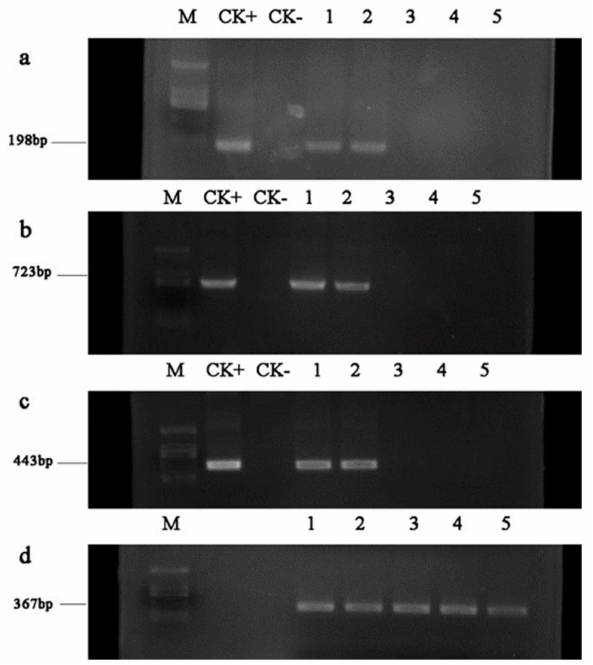
Figure 4. PCR probe of exposed-leaf DNA extracts using three AhDREB1 -specific primer pairs and ribosomal primers: ( a ) 1% agarose gel with AhDREB1 PCR products of 198 bp obtained with primers F 2 and R 2 ; ( b ) 1% agarose gel with AhDREB1 PCR products of 723 bp obtained with primers F 1 and R 1 ; ( c ) 1% agarose gel with AhDREB1 PCR products of 443 bp obtained with primers F 3 and R 3 ; and ( d ) 1% agarose gel with ribosomal PCR products of 367 bp obtained with primers F 18s and R 18s . M, D2000 DNA marker; CK+, transgenic poplar DNA; CK–, non-transgenic poplar DNA; 1–5: the